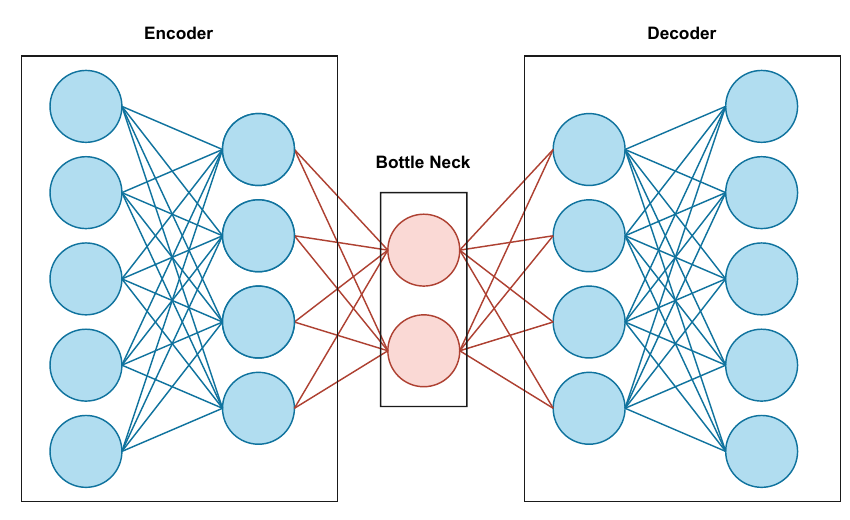
Figure 1. Autoencoder